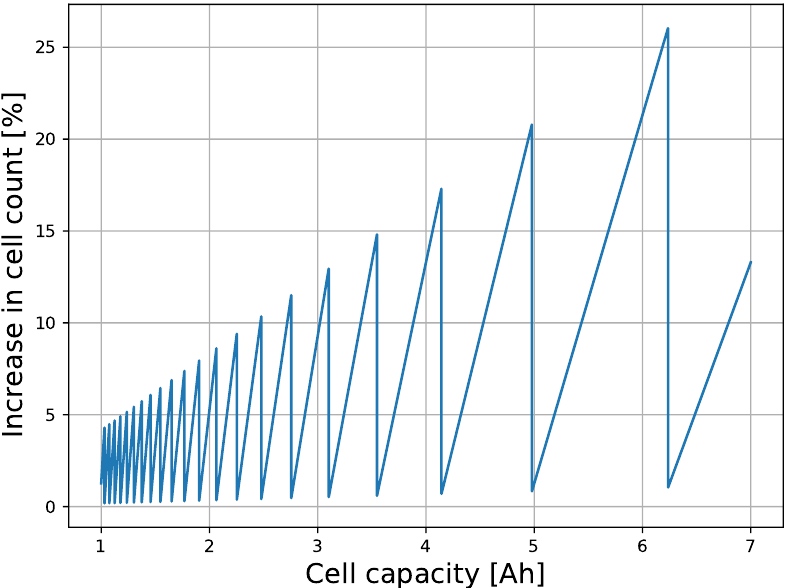
Figure 14. Relation between cell capacity and the increase in the number of cells with respect to the number before taking the configuration into